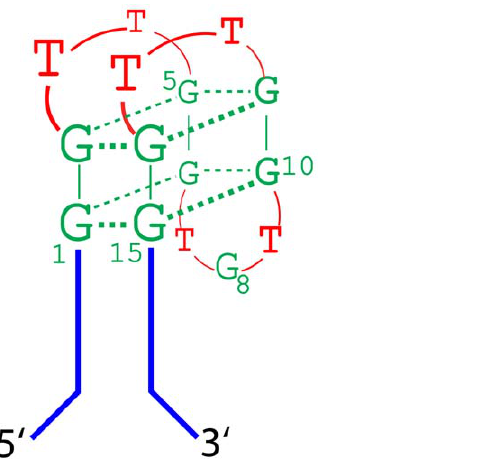
Figure 5. Folding of the canonical thrombin binding sequence. In Thb1 the 15mer hairpin loop folds into the G-quadruplex structure on the stem and tails shown in Figure 1.